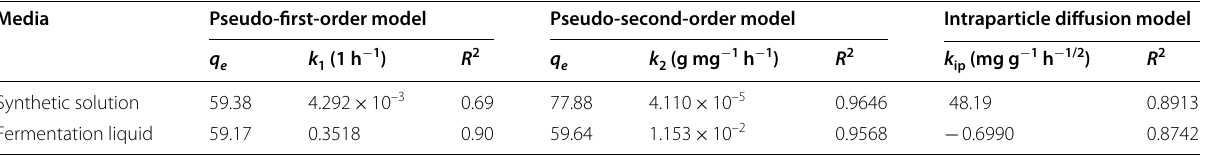
Table 2 Parameters of adsorption kinetics